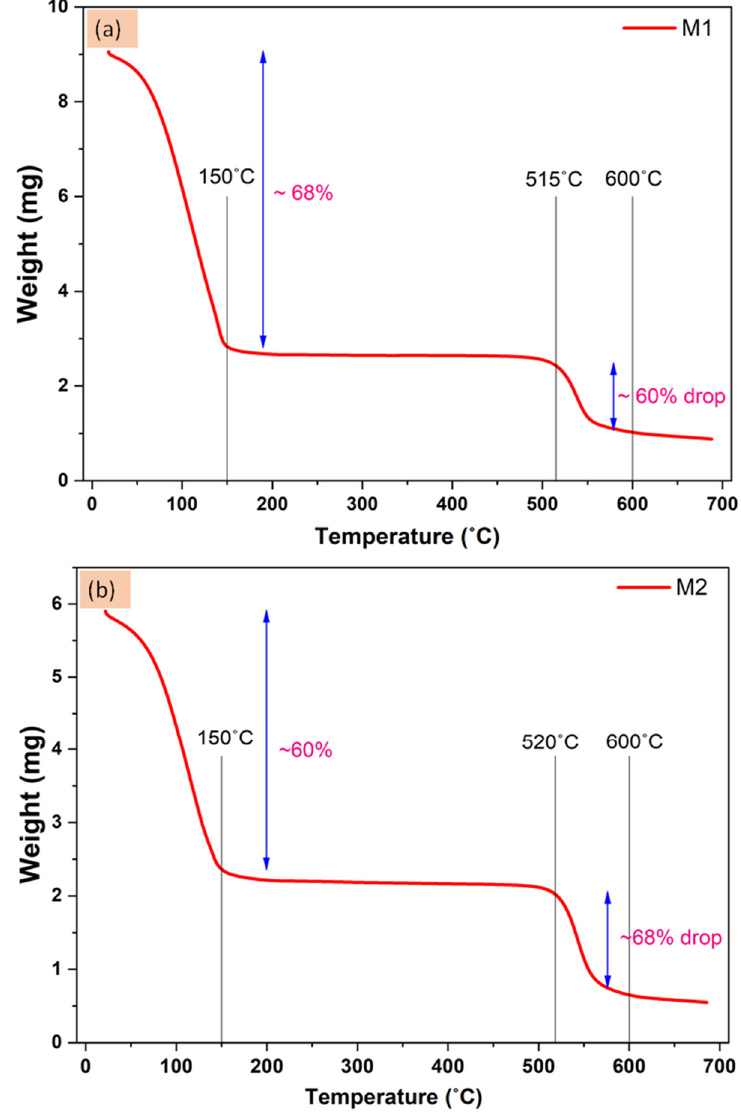
Figure 7. TGA analysis graph of the prepared ( a ) M1 and ( b ) M2 membrane.